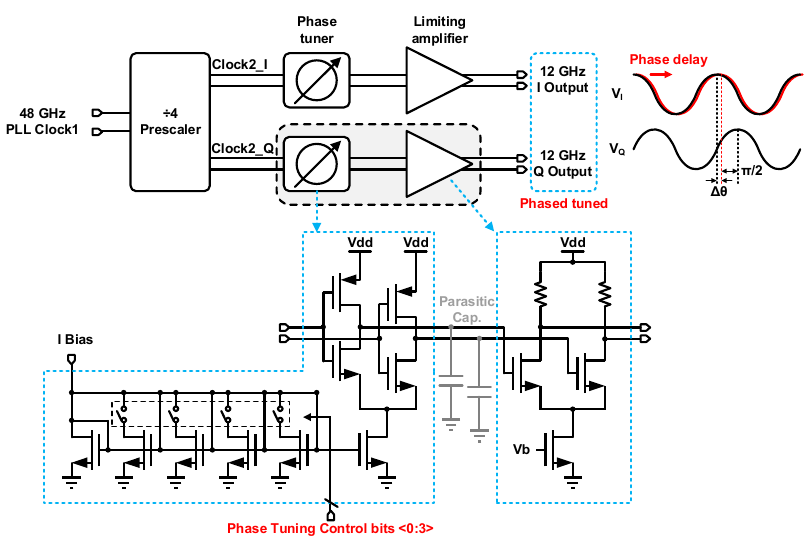
Figure 14. Diagram of the phase tuning circuits.